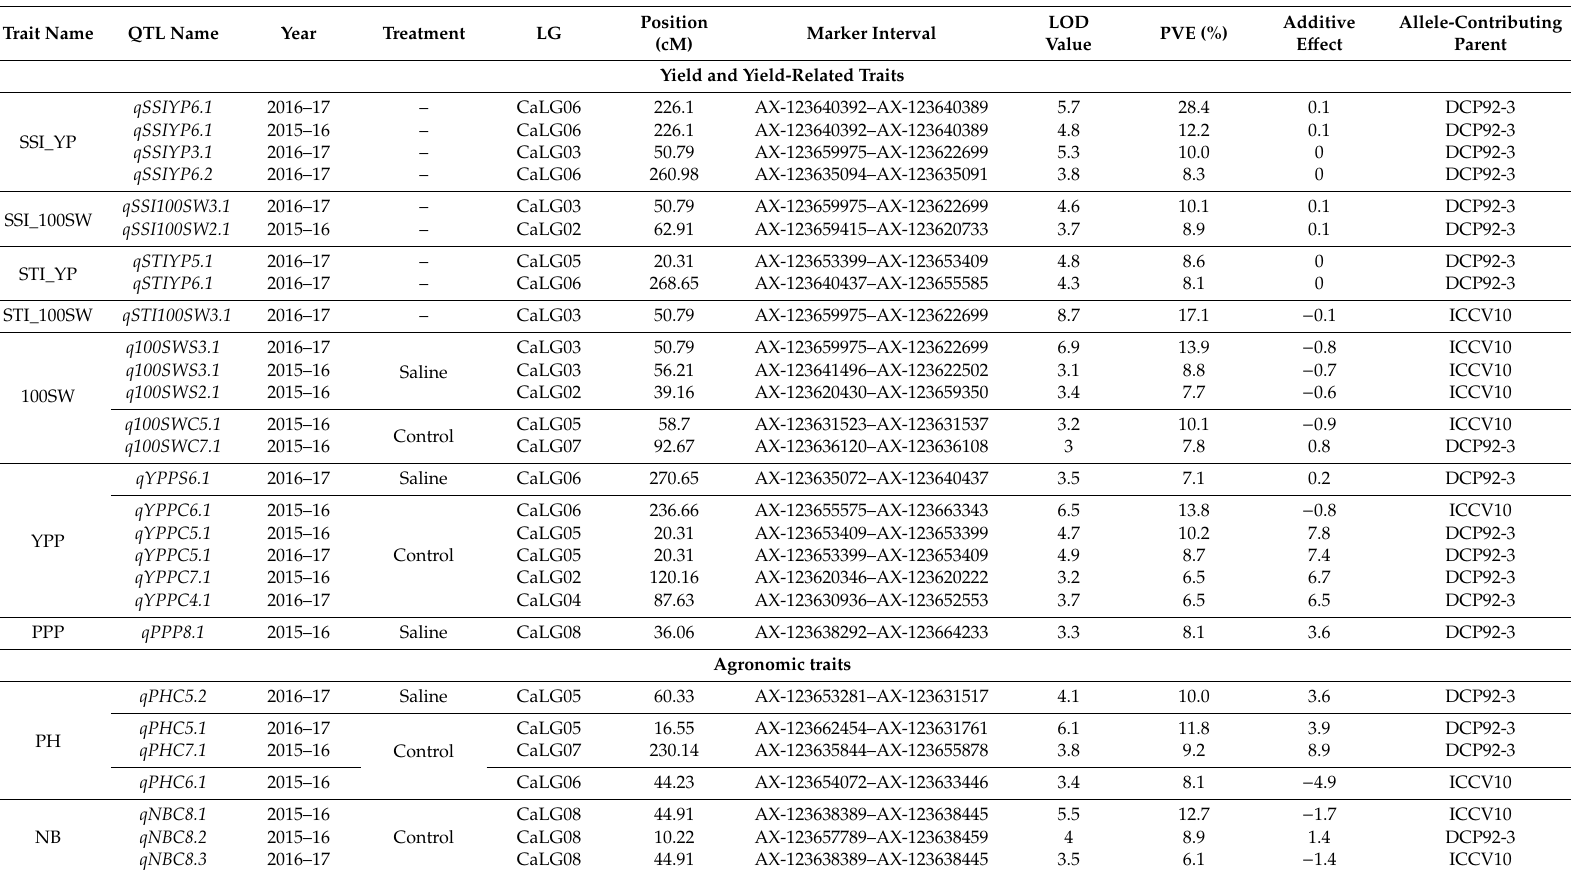
Table 4. Summary of the major and minor QTLs for various salinity tolerance component